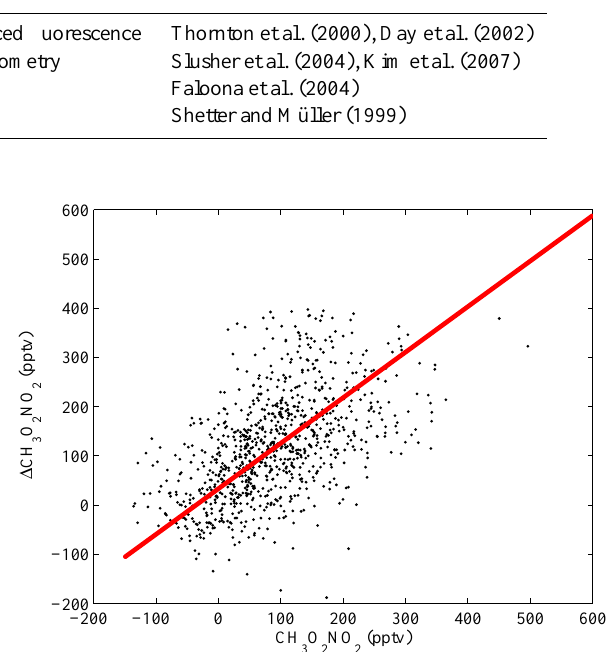
Figure 8. CH 3 O 2 NO 2 inferred ( (cid:49) CH 3 O 2 NO 2 ) as the difference of the total peroxy nitrates minus PAN, PPN, and HO 2 NO 2 com- pared to CH 3 O 2 NO 2 observed by TD-LIF at temperatures between 220 and 230K (Table 3). The red line is a weighted fit to the data: slope of 0.93 ( ± 0.07) and intercept of − 33.0 ( ± 5.9)pptv. The uncertainties used in the calculations are ± 40% + 20pptv for CH 3 O 2 NO 2 , ± 15% + 20pptv for SPNs, ± 15% + 2pptv for PAN, ± 20% + 1pptv for PPN, and ± 30% + 1pptv for HO 2 NO 2 . The R 2 of the fit is